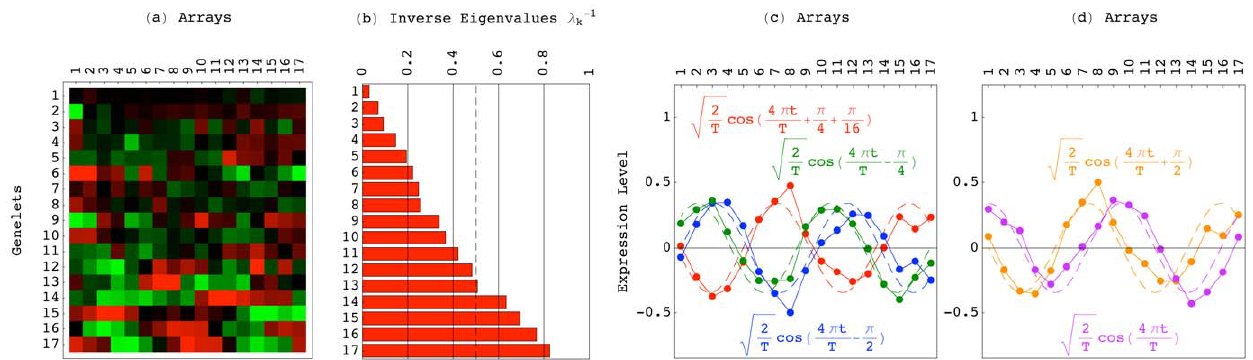
Figure 2. Genelets or right basis vectors. ( a ) Raster display of the expression of the 17 genelets, i.e., HO GSVD patterns of expression variation across time, with overexpression (red), no change in expression (black) and underexpression (green) around the array-, i.e., time-invariant expression. , showing that the 13th through the 17th genelets correspond to 1 l k 2 . ( c ) Line- ( b ) Bar chart of the corresponding inverse eigenvalues l { 1 k joined graphs of the 13th (red), 14th (blue) and 15th (green) genelets in the two-dimensional subspace that approximates the five-dimensional HO GSVD subspace (Figure S4 and Section 2.4), normalized to zero average and unit variance. ( d ) Line-joined graphs of the projected 16th (orange) and 17th (violet) genelets in the two-dimensional subspace. The five genelets describe expression oscillations of two periods in the three time courses.